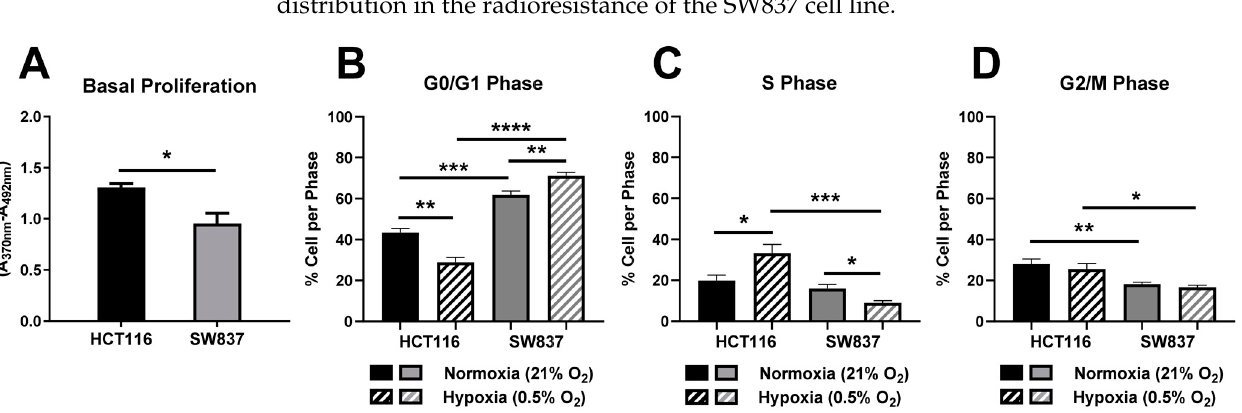
Figure 2. Basal proliferation and cell cycle distribution in HCT116 and SW837 cells. ( A ) Proliferative rates were assessed by BrdU ELISA in HCT116 and SW837 cells. Cell cycle distribution was assessed after 24 h culture under hypoxia (0.5% O 2 ) or normoxia (21% O 2 ). ( B ) Proportion of HCT116 and SW837 cells in G0/G1 phase under normoxia and hypoxia. ( C ) Proportion of HCT116 and SW837 cells in S phase under normoxia and hypoxia. ( D ) Proportion of HCT116 and SW837 cells in G2/M phase under normoxia and hypoxia. Data are presented as means ± SEMs for four independent experiments. Statistical analysis was performed by paired/unpaired t- testing, as appropriate. * p < 0.05, ** p < 0.01, *** p < 0.001, **** p < 0.0001.